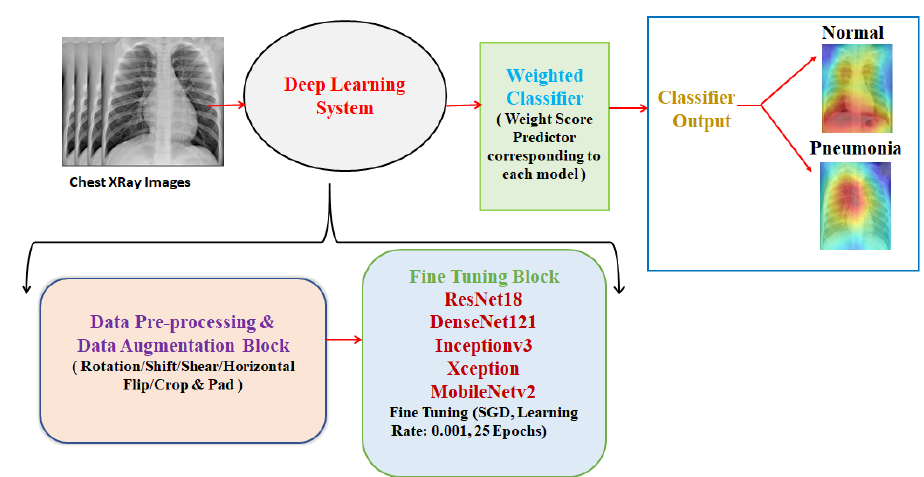
Figure 3. Block diagram of the proposed methodology (deep learning system consists of the data pre-processing and data augmentation block and the fine-tuning block; the weighted classifier gives the final